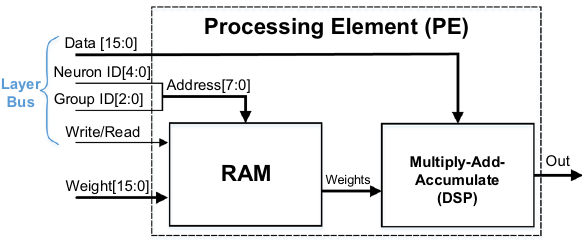
Fig. 12 FPGA logic design for one processing element (PE). Ran- dom access memory unit (RAM) stores node weights. Multiply-add- accumulateunit(MAC)implementsarithmeticoperationsusingasingle